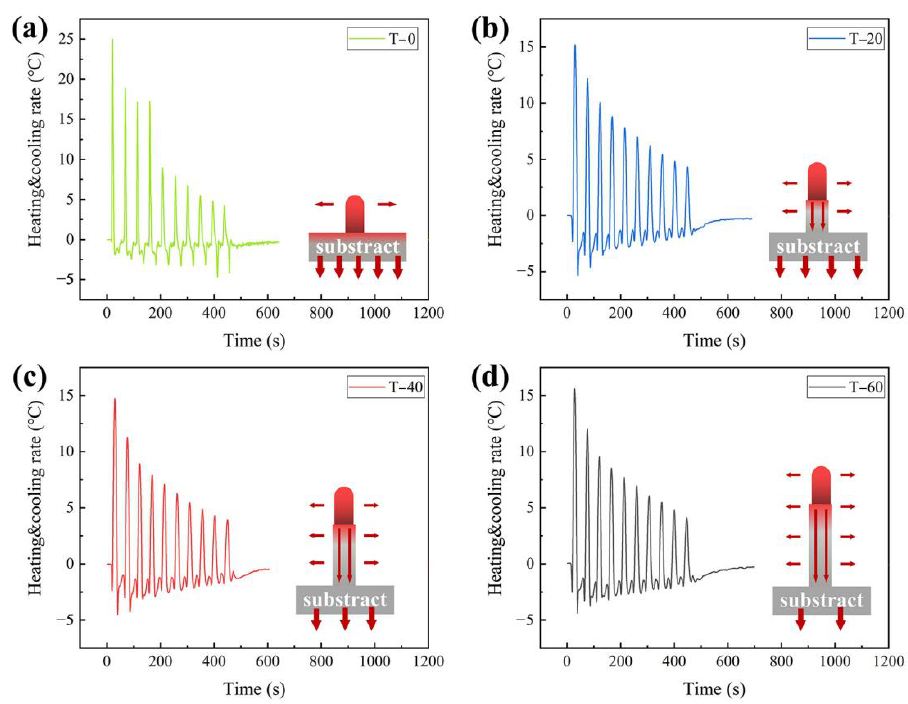
Figure 6. Heating and cooling rate curves of LMD-Al 0.5 FeCoCrNi walls: ( a ) T-0; ( b ) T-20; ( c ) T-40; ( d ) T-60.